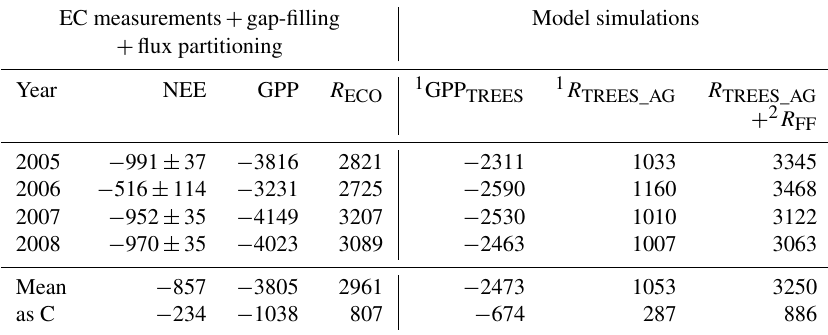
Table 2. EC-measured (and gap-filled and partitioned) annual net ecosystem exchange (NEE ± error; Appendix B), gross primary production (GPP) and ecosystem respiration ( R ECO ) of the Kalevansuo peatland, in comparison with the simulated tree stand GPP (GPP TREES ) , tree stand above-ground respiration ( R TREES_AG ) and forest floor respiration ( R FF ) . Unit: gCO 2 m − 2 a − 1 . EC measurements + gap-filling